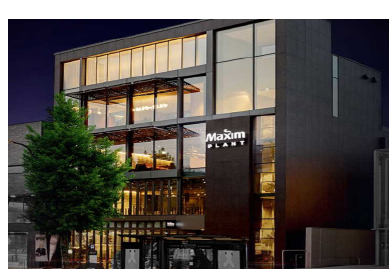
Figure 11. Maxim Plant (2018, Seoul, Korea).